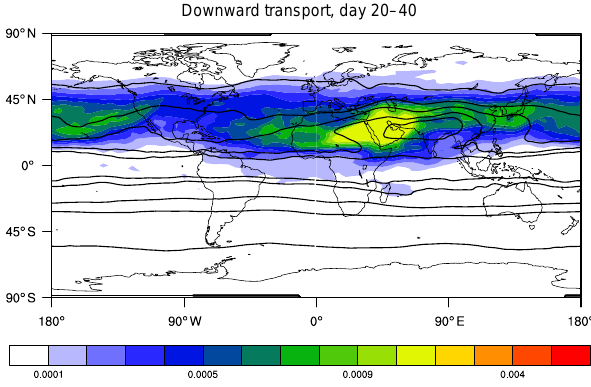
Figure 13. Mean JJA distribution of diabatic trajectories (in per- centage of total number of trajectories) that are transported down- ward (to > 250hPa) averaged over day 20 to 40 after their release in the anticyclone at 360K, overlaid with mean JJA PV (contours at ± 0.7, 1, 2, 4 and 8PVU).